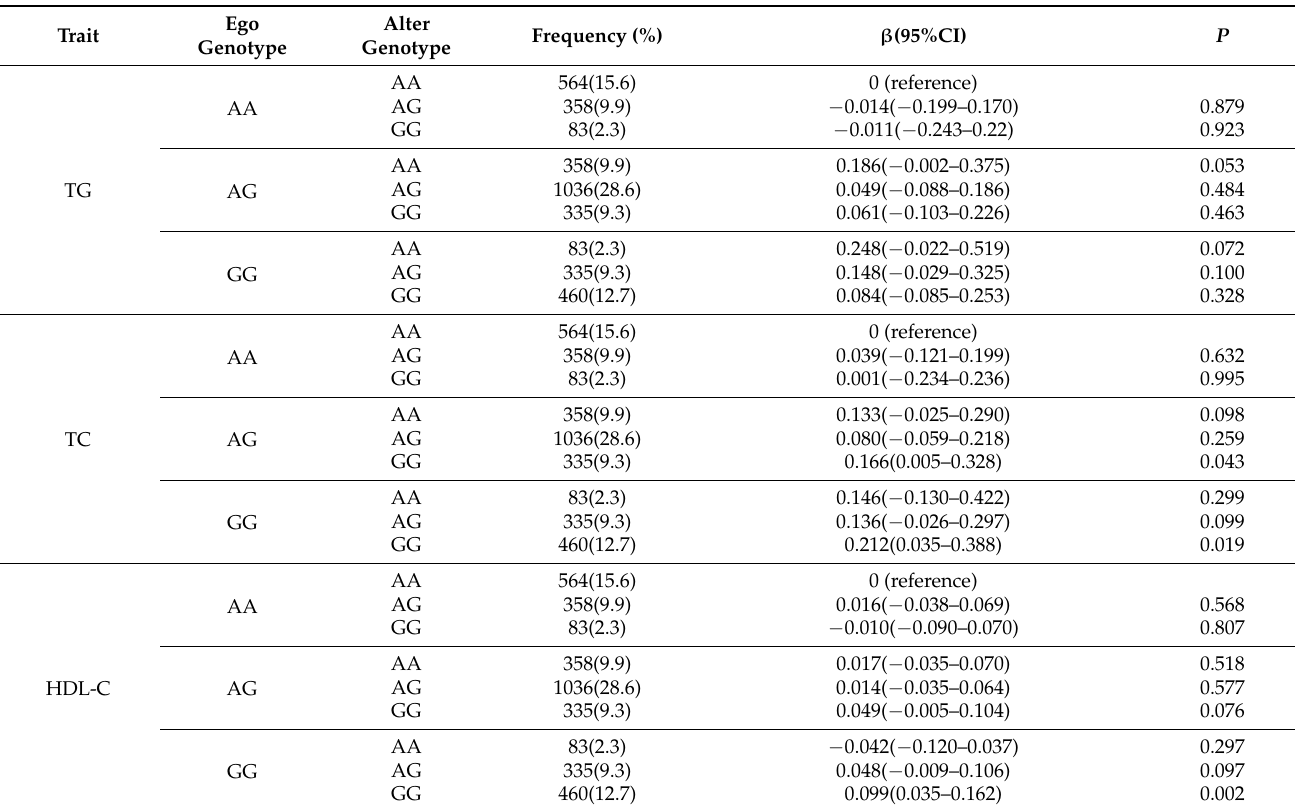
Table 3. The associations with lipid levels for the rs182052 ego and alter